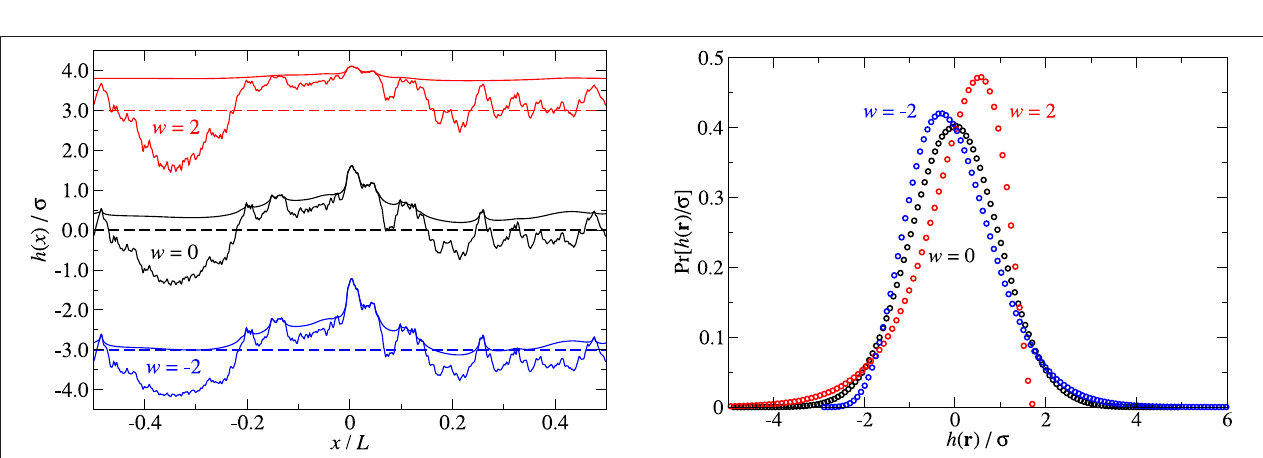
2, w 0, w 2) at approximately 10% relative = = = − 2 are shifted by a constant to improve = ± ×